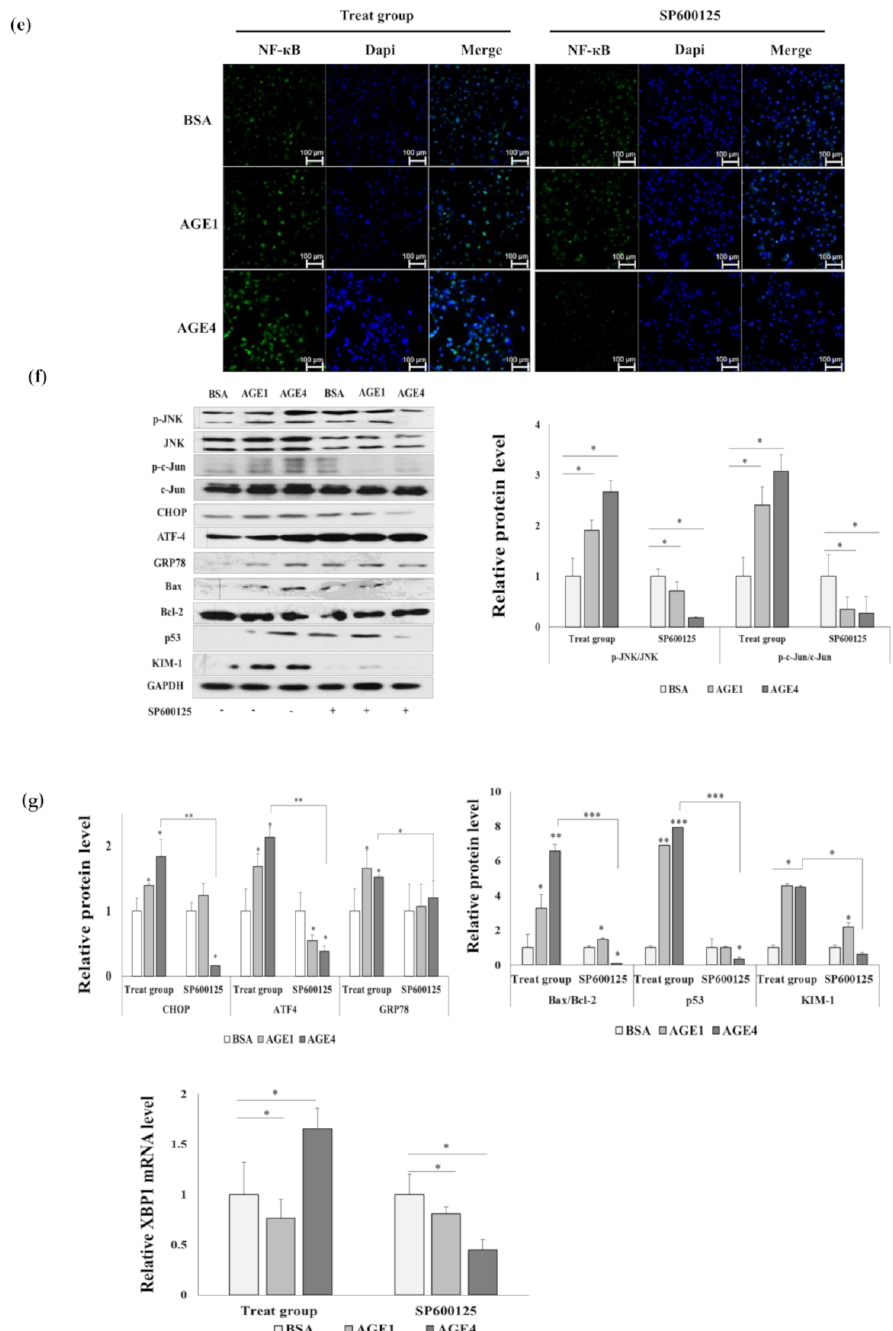
Figure 2. Effects of AGE4 on the ER stress and apoptosis through JNK signaling pathway in HK-2 cells. ( a ) With 200 µ g/mL of AGE4 treatment for 24 h, the levels of phosphorylated c-Jun, JNK, ERK, and p38 protein were measured using Western blotting. ( b , c ) NF- κ B translocation is represented by an increase in nucleus/cytoplasm ratio observed in the stained HK-2 cells shown from Western blot and immunofluorescence (IF) analysis. ( d , e ) NF- κ B induction by AGE4 was inhibited by pretreatment with a JNK signal inhibitor (10 µ M SP600125) shown from Western blot and IF analysis. Plus sign represents the presence of SP600125. Minus sign represents the absence of SP600125. ( f ) The protein expression levels of p-JNK, JNK, p-c-Jun, c-Jun, CHOP, ATF4, GRP78, Bax, Bcl2, p53, KIM-1, and GAPDH were detected using Western blot. Densitometric analysis was performed using ImageJ, and the ratio of the expression of the target protein to that of GAPDH was calculated. ( g ) The mRNA expression level of XBP1 was detected using q-RT-PCR. Data are expressed as the mean ± standard deviation (SD) of at least three independent experiments. The groups were compared using a Student’s t -test, and the levels of statistical significance are indicated as follows: * p < 0.05, ** p < 0.01, and *** p <